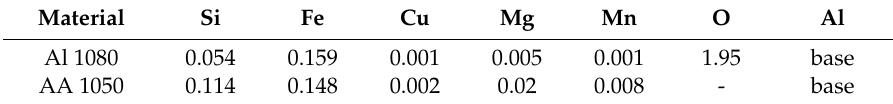
Table 1. Chemical composition of as-atomized Al1080 powder and as-cast A1050 ingot in wt.%.